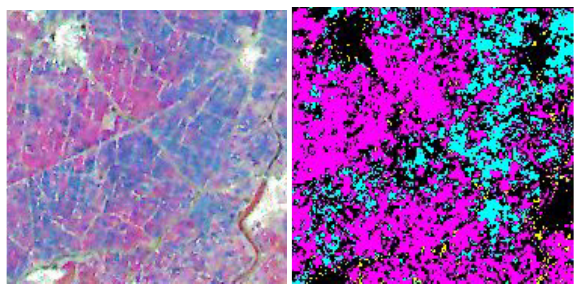
Figure 11: RISAT-1 Multi temporal image (2016) (left) and classified (right) parts of West Godavari district of Andhra Pradesh